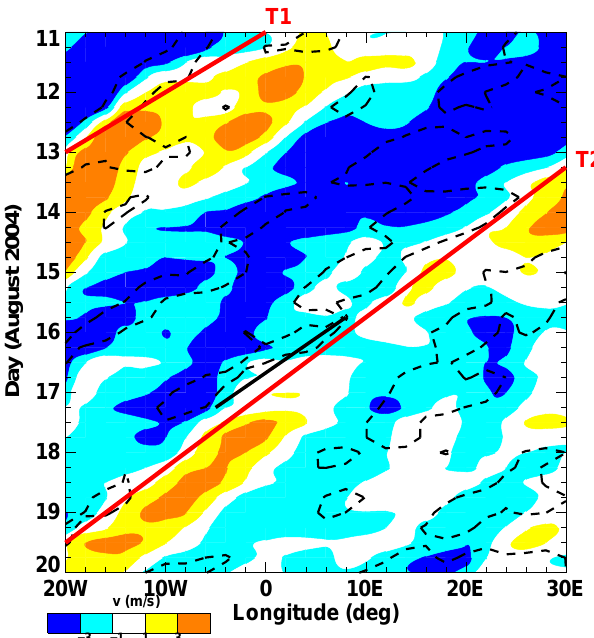
Fig. 2. Time-longitude diagram of 700-hPa meridional wind (color) and MSG 10.8-µm BT contour at 265K (dashed line) averaged over 5 ◦ –15 ◦ N from 11 to 20 August 2004. The black thick line indicates the location of the MCS in the simulation while the two red lines show the position of the troughs T1 and